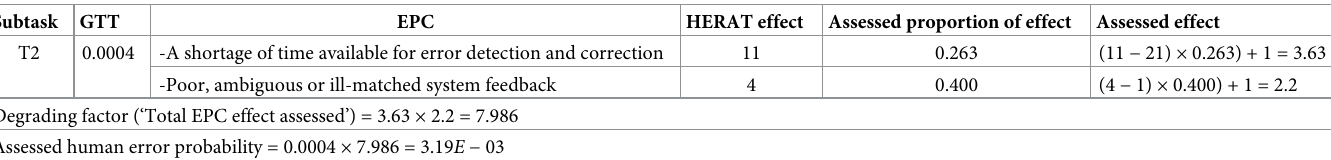
Table 9. HEART calculations of EPC1 for subtask